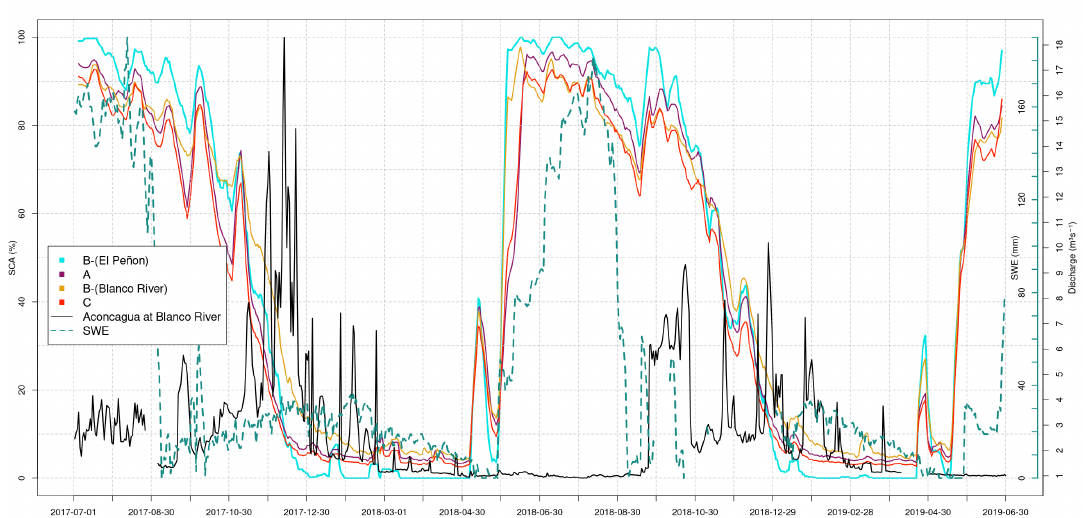
Figure 5. Percentage of the total snow covered area for each sub-basin composing the Aconcagua River catchment area along the analyzed period (2017–2019). The SWE refers to the snow water equivalent in mm, at Portillo station, and Aconcagua at Blanco River refers to the streamflow of the Aconcagua river after the join of the Juncal and Blanco rivers. Both, SWE and streamflow, were measured by Direcci ó n General de Aguas de Chile